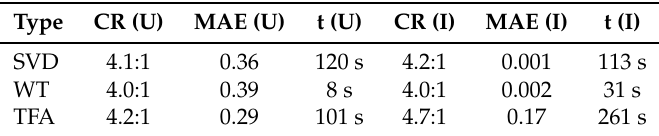
Table 1. Compression factor, MAE and processing time of different compression approaches for U noise and I DS